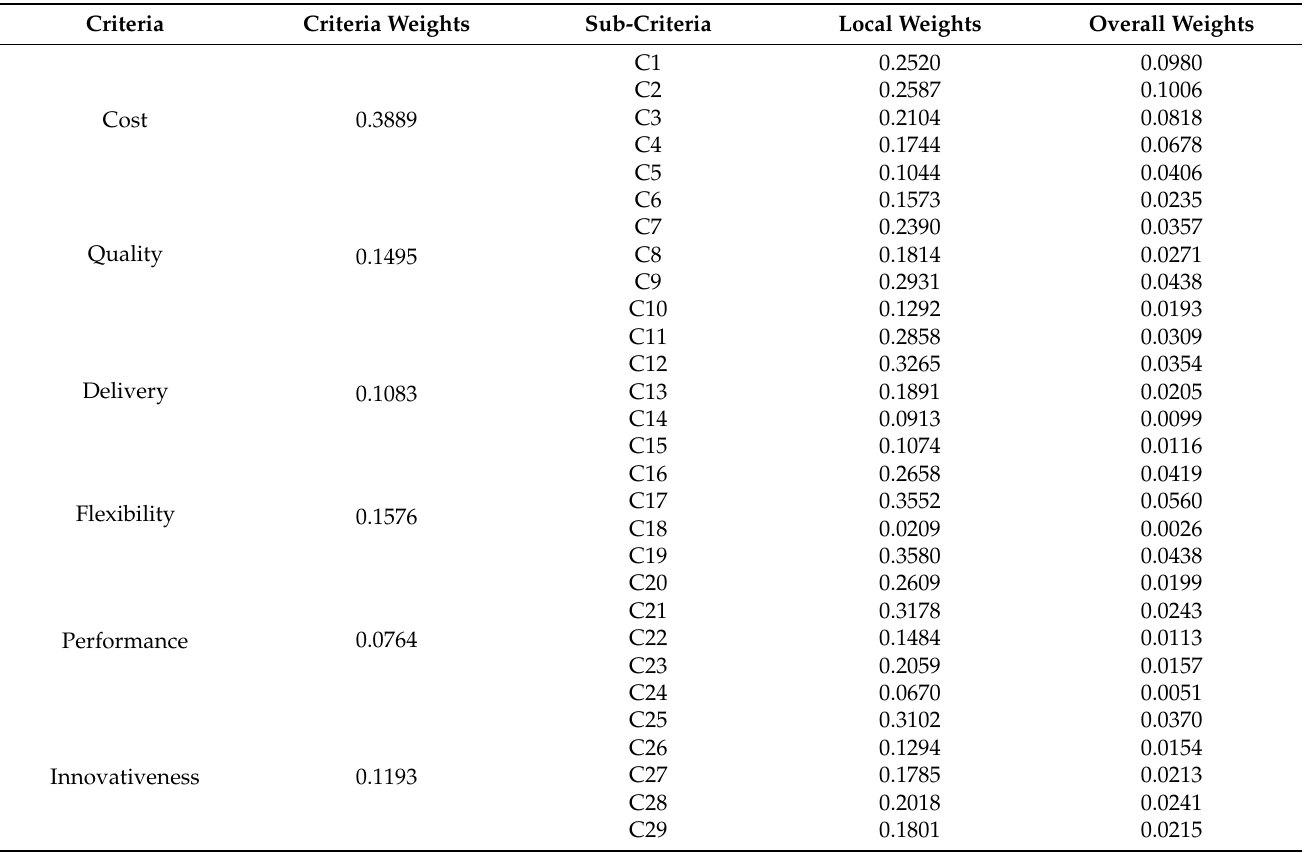
Table 6. Summary of weights obtained from the AHP